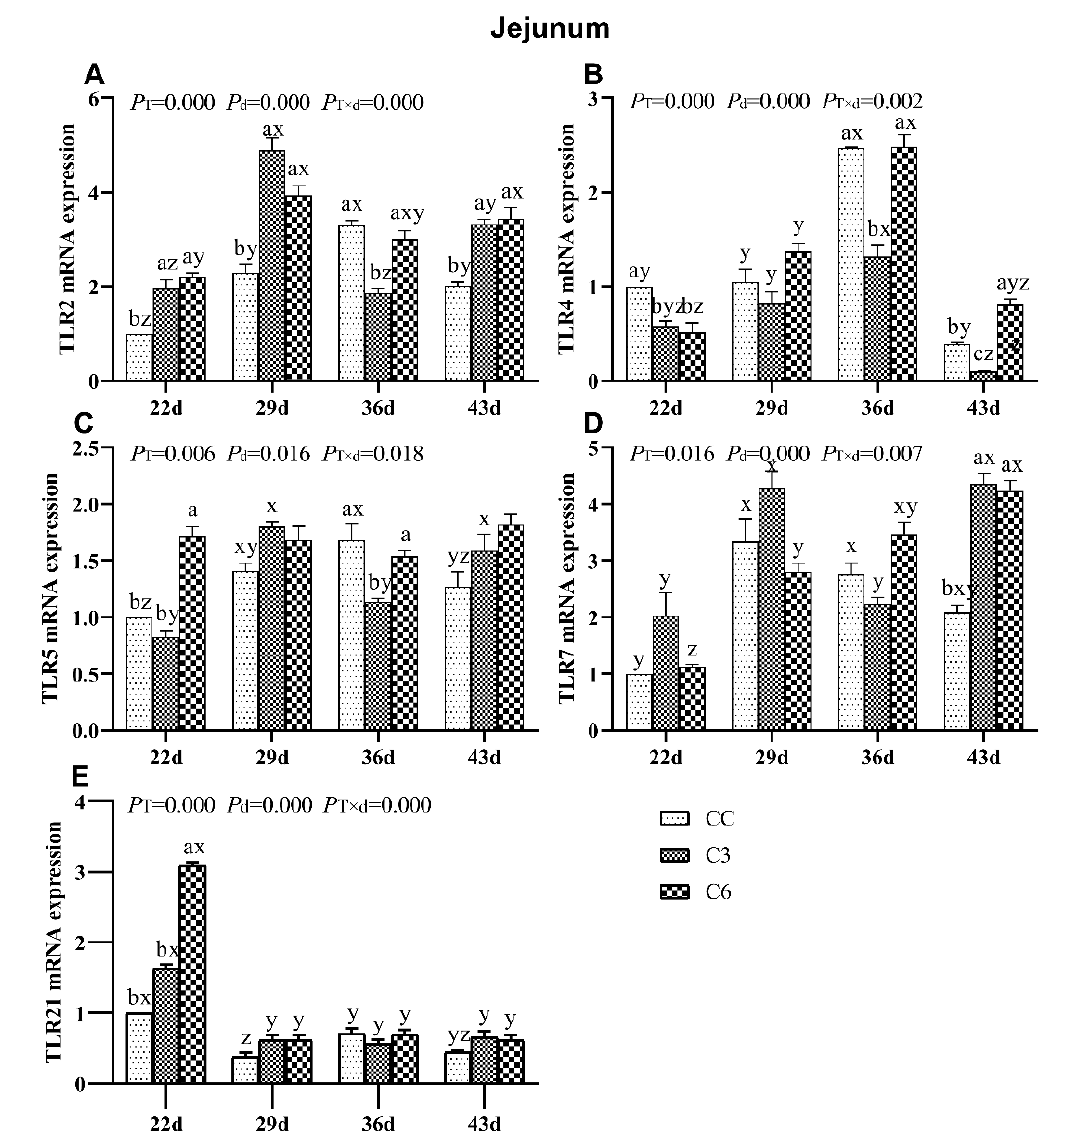
Figure 7. mRNA levels of Toll-like receptors TLR2 ( A ), TLR4 ( B ), TLR5 ( C ), TLR7 ( D ), and TLR21 ( E ) in the jejunum of broilers. Di ff erent letters indicate significant di ff erences ( p < 0.05) between treatment groups (a, b, c) and days of age (x, y,